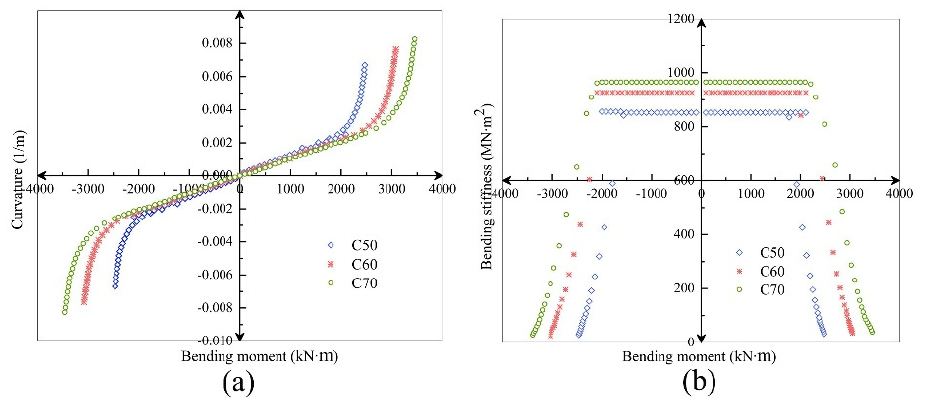
Figure 19. Comparison of M – K ( a ) and K θ – ϕ ( b ) relationship curves of C 50/ C 60/ C 70 segmental joints ( N = 20,000 kN).